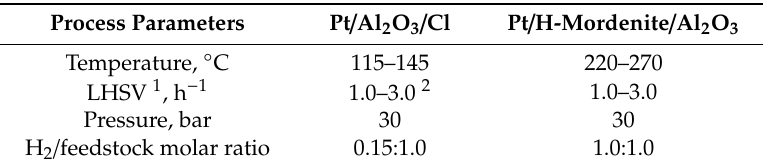
Table 3. The process parameters of the